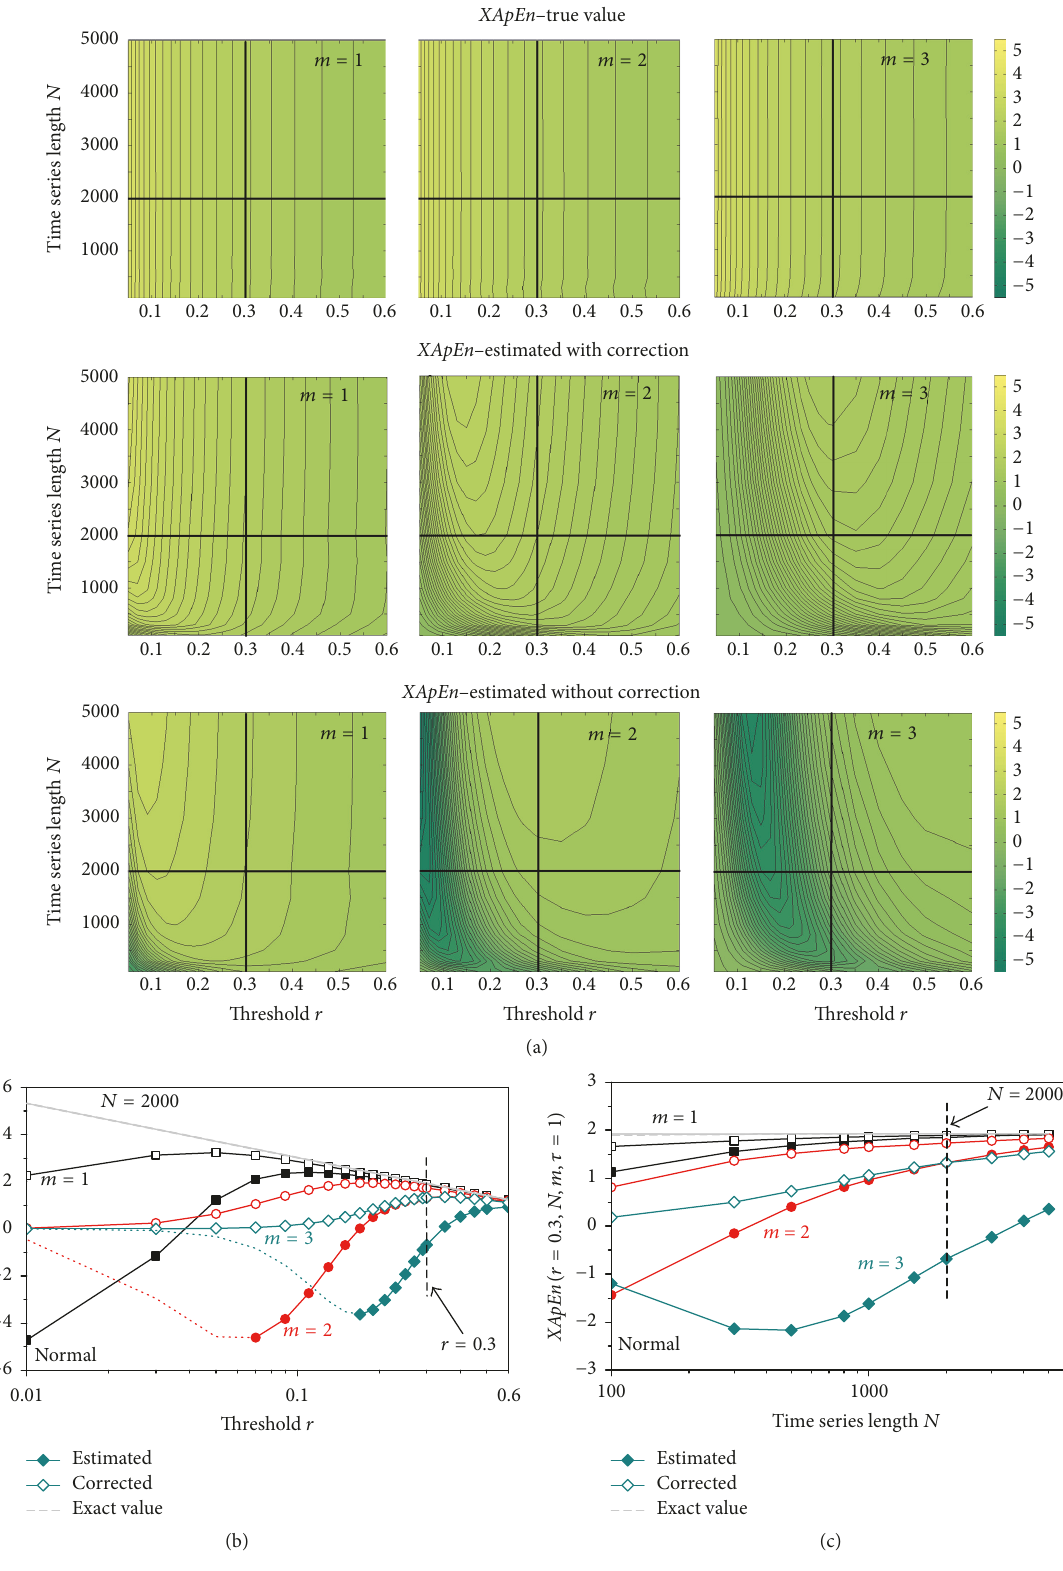
Figure 7: XApEn of artificial data with normal distribution in threshold-length ( r - N ) plane, for 𝑚 = 1, 2 , and 3. The three rows of (a) show, respectively, calculated (true) XApEn , XApEn estimated with correction, and XApEn estimated omitting log (0) . Dark green color corresponds to XApEn estimated within the unstable N - r - m parameter region. Light green indicates low XApEn , while yellow color indicates high XApEn . Horizontal cuts at 𝑁 = 2000 are presented as line graph in (b); vertical cuts at 𝑟 = 0.3 are presented as line graph in